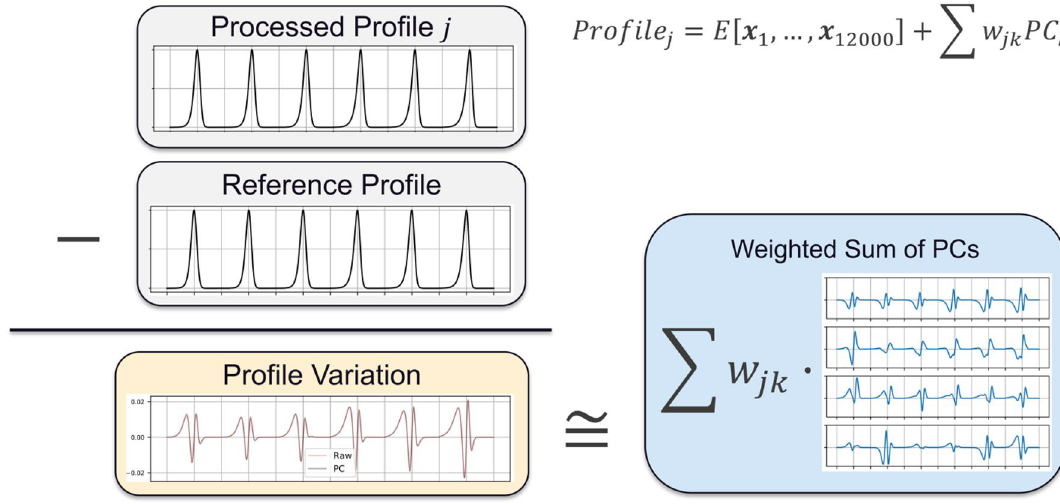
Figure 11. Schematic of how the principal component analysis reproduces a processed profile from principal components.